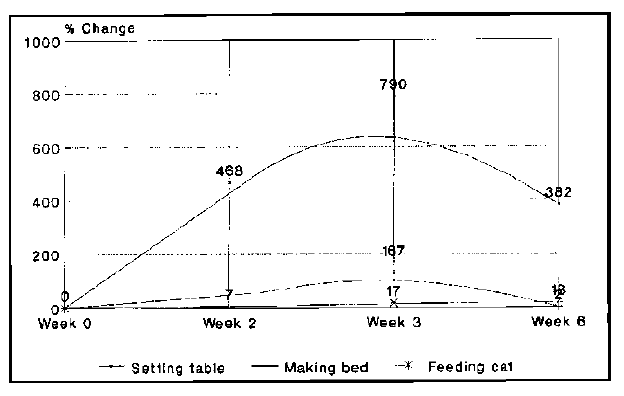
FIGURE 3: Subject: Selected sub-skills of communi- cation skills and independence (all action routines) FIGURE 4: Subject: communication skills